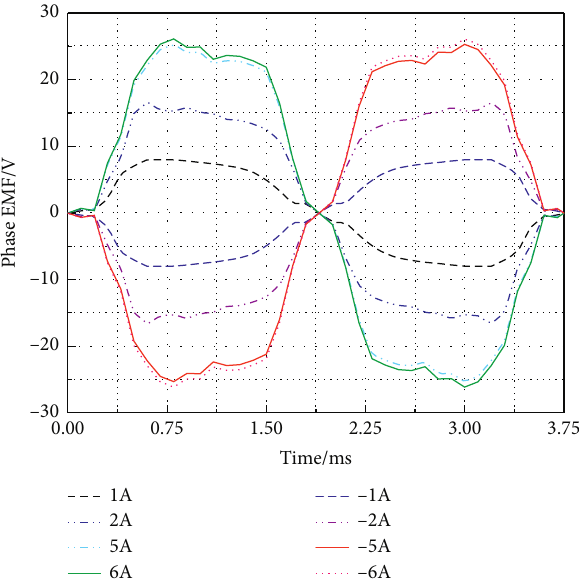
Figure 15: EMF of the PMCHEG only with electric excitation source.